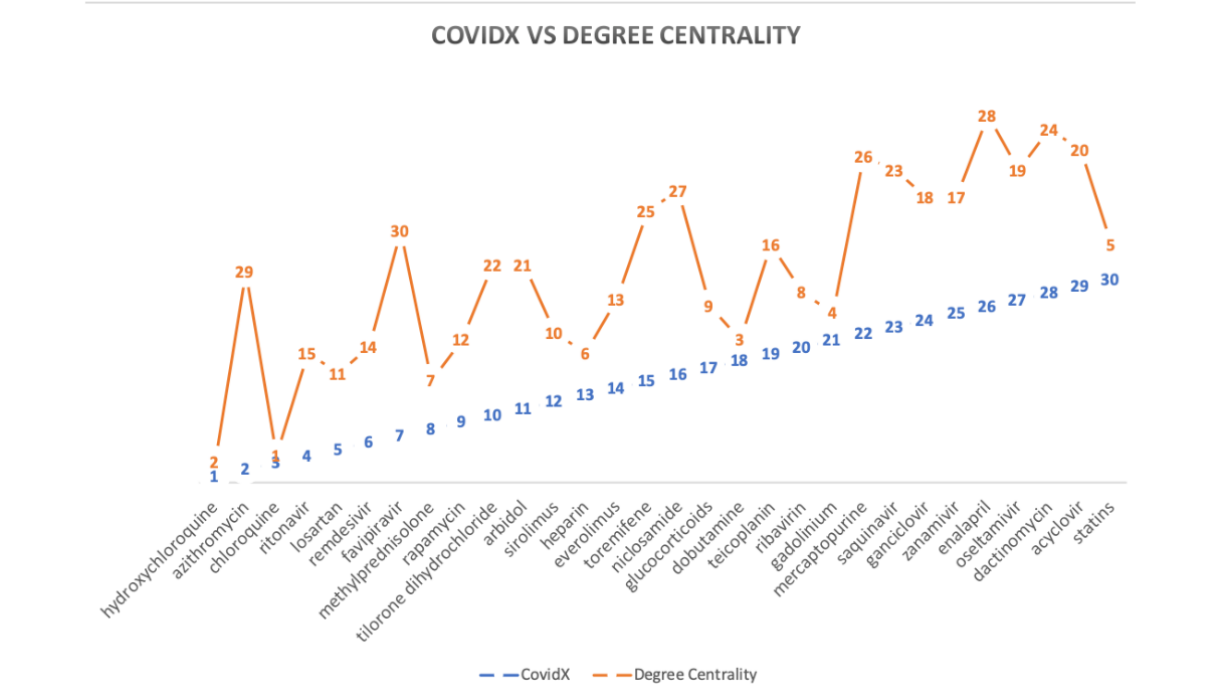
Figure 5. How the degree of centrality as a ranking mechanism is compared to the CovidX algorithm. The horizontal axis is the drugs listed in alphabetical order, and the vertical axis shows the